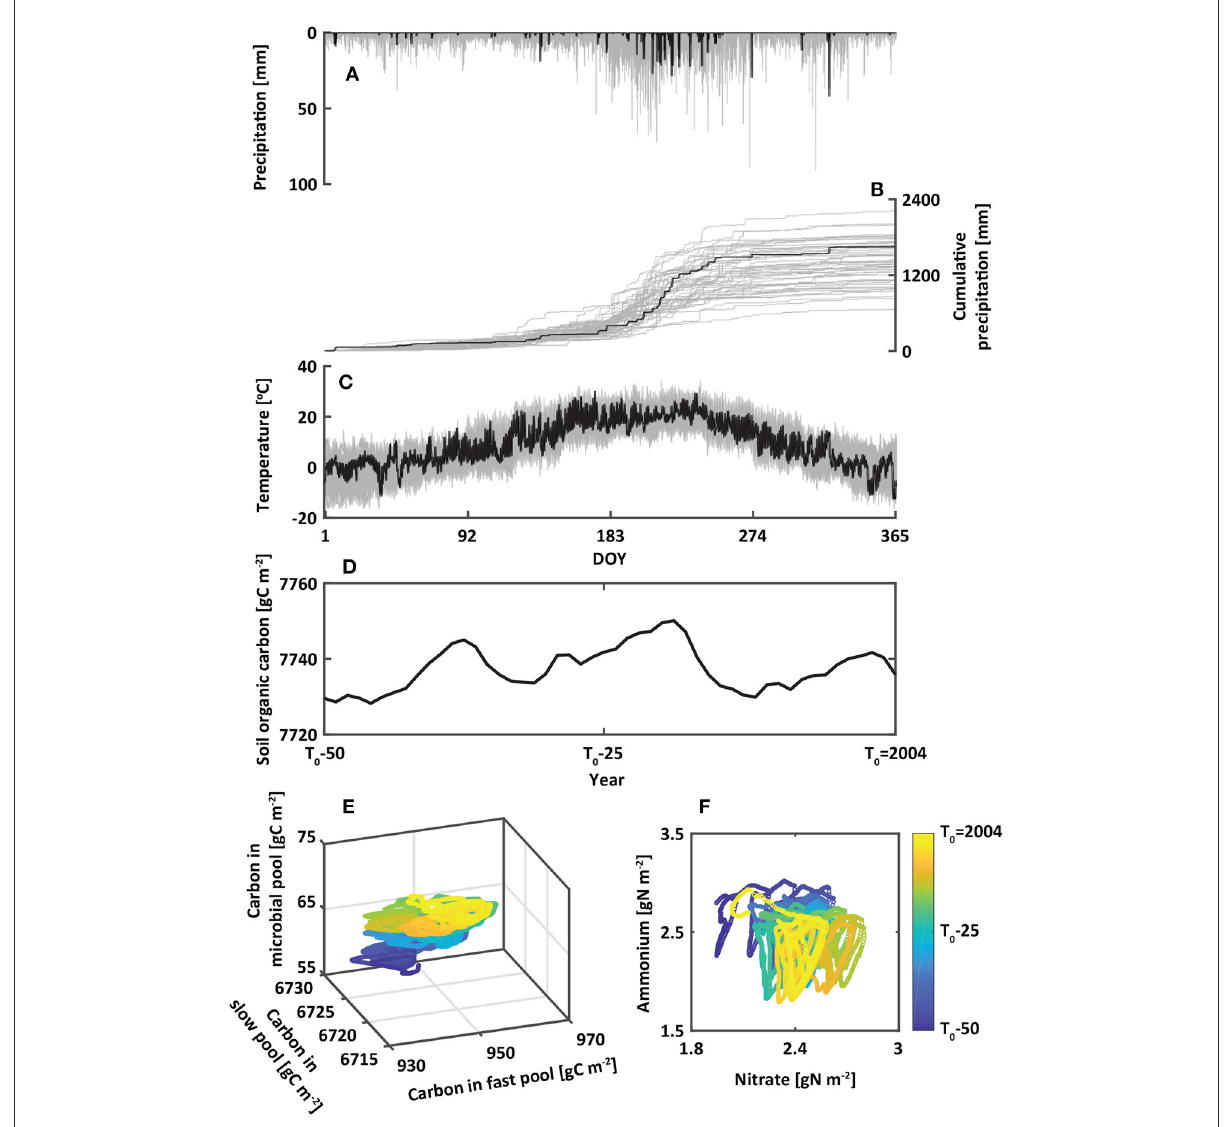
FIGURE2 Forcings and initial conditions implemented in the simulation. Observed (A) hourly precipitation, (B) cumulative hourly precipitation, and (C) temperature in 2020 (black) overlaid on the ensemble of generated 50-year weather variables (gray). The nonlinear dynamics in (D) soil organic carbon (SOC), (E) organic carbon pools, and (F) inorganic nitrogen pools during the 50-year spin-up period before 2004 to reach a statistical equilibrium state for initial